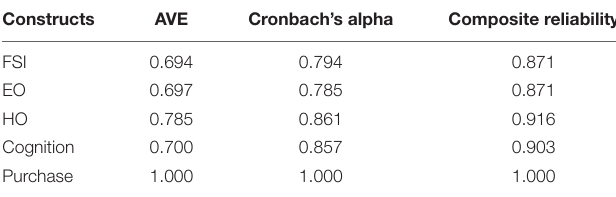
TABLE 4 | AVE, Cronbach’s alpha and composite reliability.